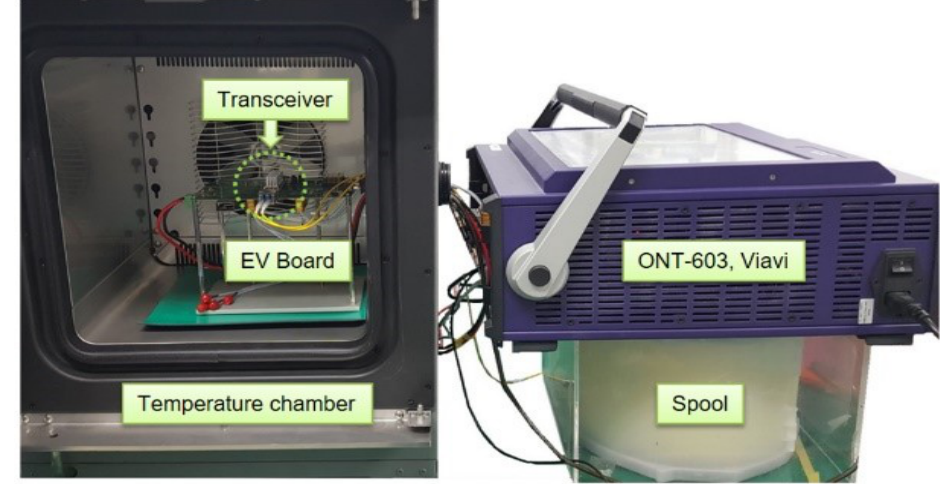
Figure 11. QSFP28 test-bed configuration images